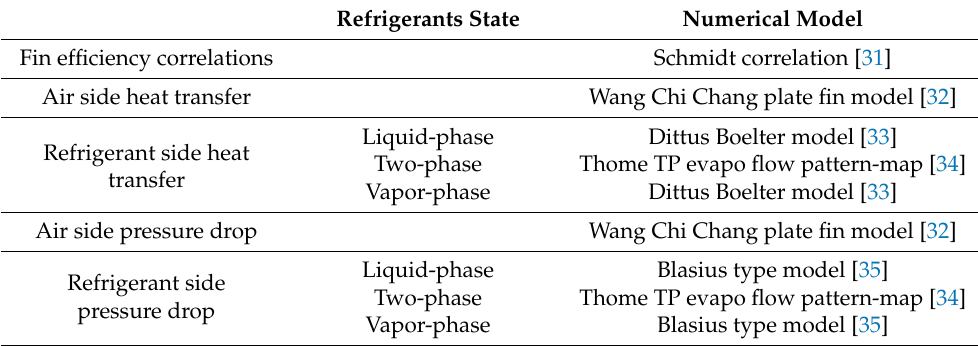
Table 4. Numerical models applied to simulation method.